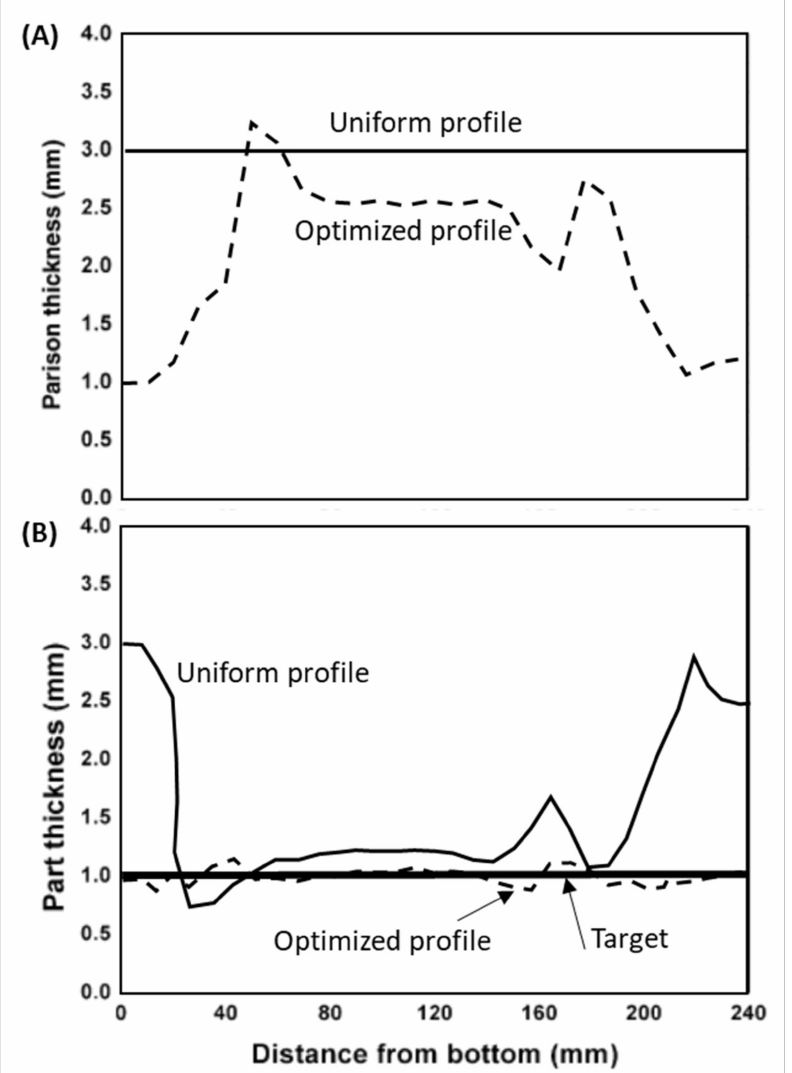
Figure 3. Optimization of the parison thickness profile for extrusion blow-molding: ( A ) Initial uniform and optimized parison profile; ( B ) Part thickness profile after blowing obtained from uniform and optimized parison profiles, together with the target profile (adapted from